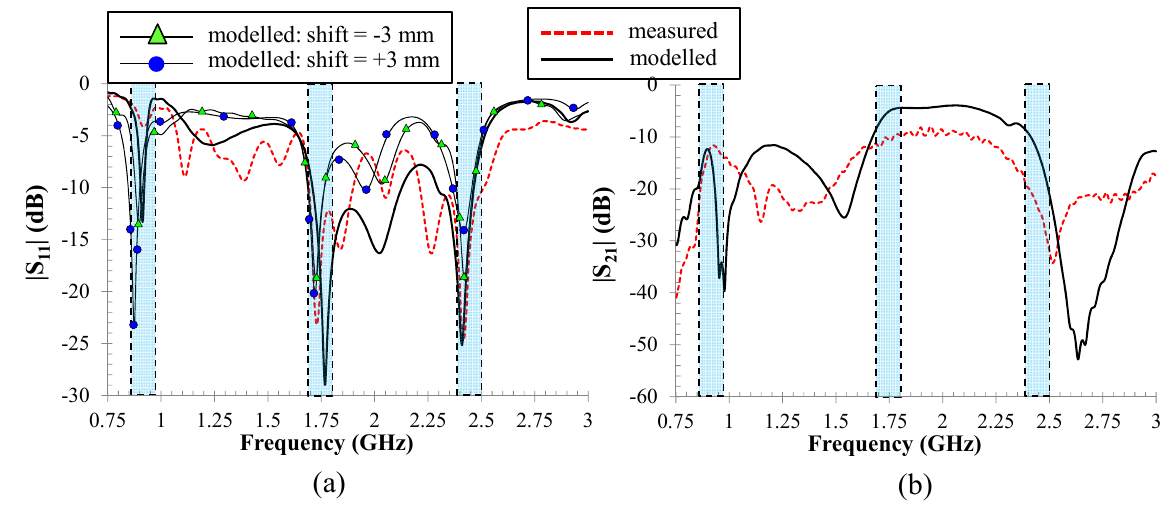
Figure 7. ( a ) Measured and simulated reflection coefficient of the two-port ring antenna and simulated reflection coefficient dependence on pile-Kapton substrate misalignment.